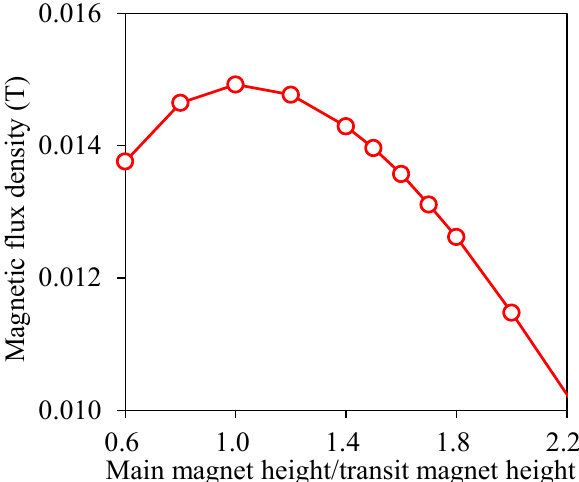
Figure 8. Variation of magnetic flux density according to the ratio of the main magnet height ( h m ) to the transit magnet height ( h t ).